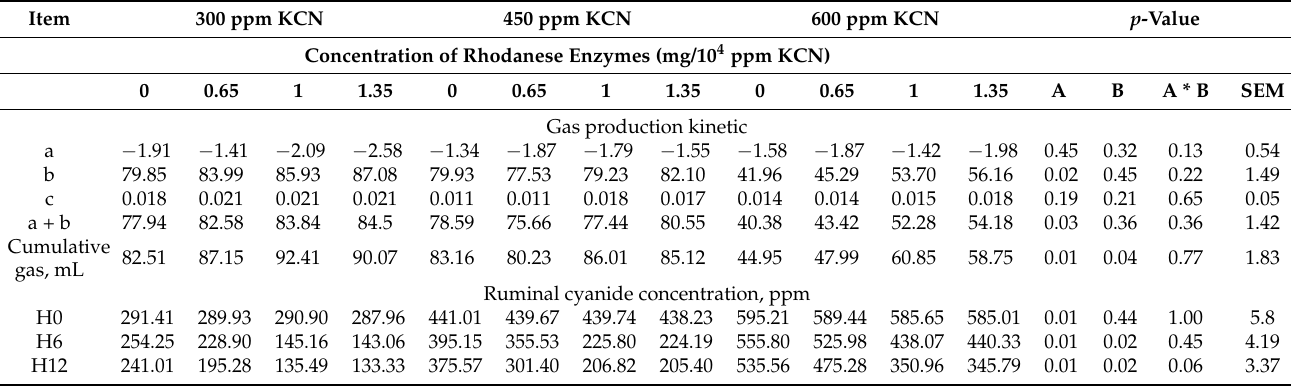
Table 2. Addition of rhodanese enzymes and potassium cyanide (KCN) levels on gas kinetics, cumulative gas at 96 h after incubation and ruminal cyanide concentration.